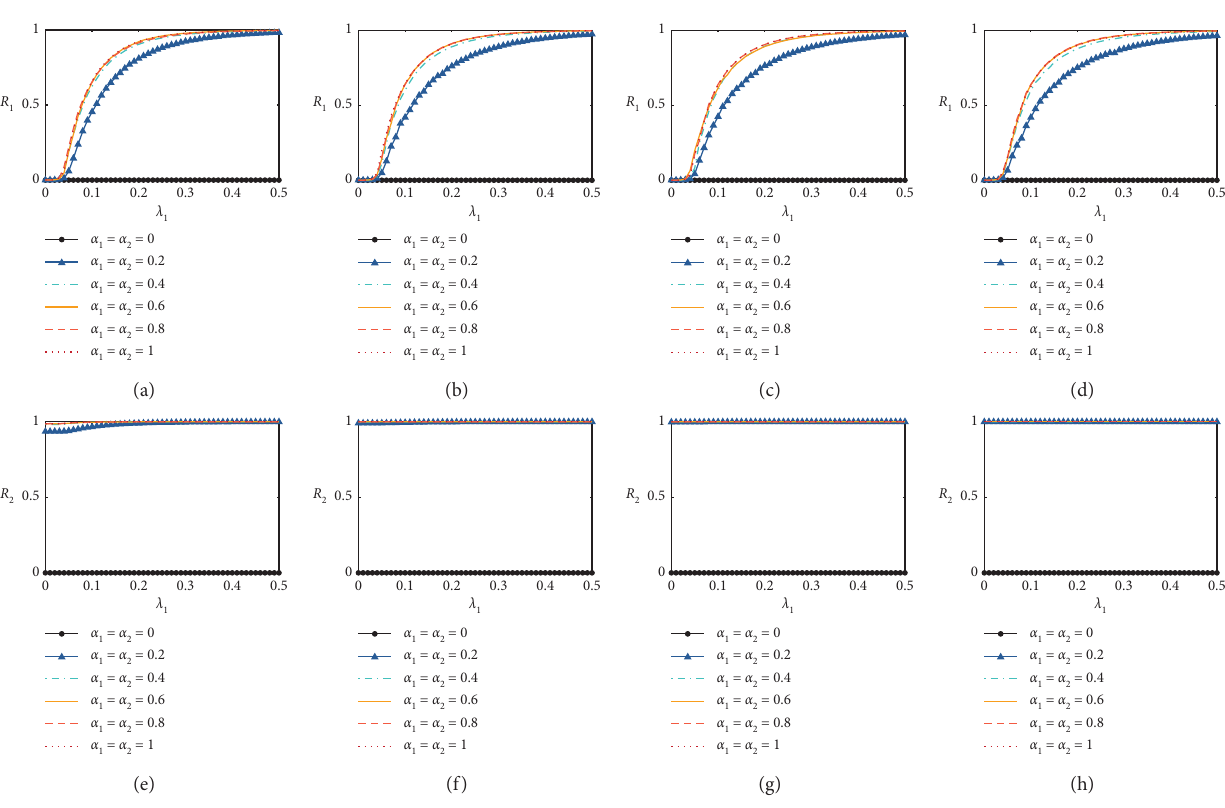
versus λ 1 1 � 0 . 8. Other 2